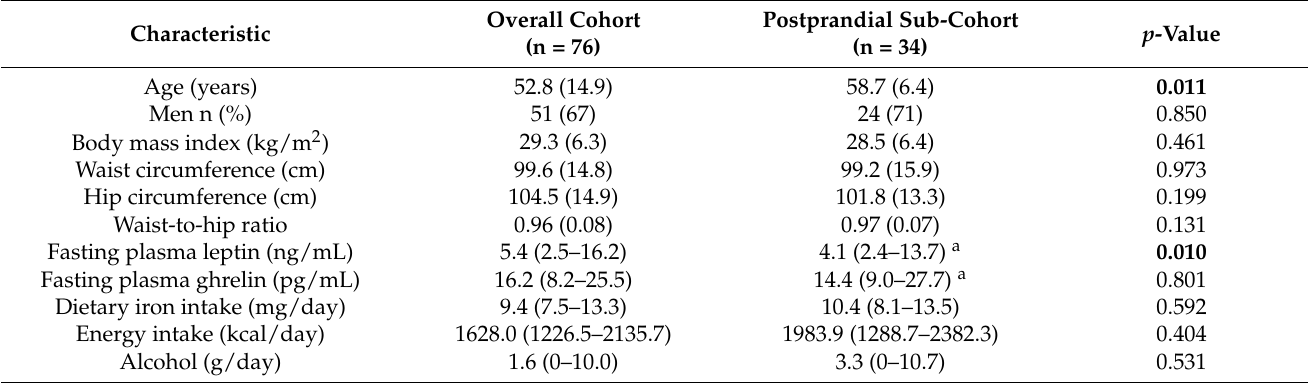
Table 1. Characteristics of the study